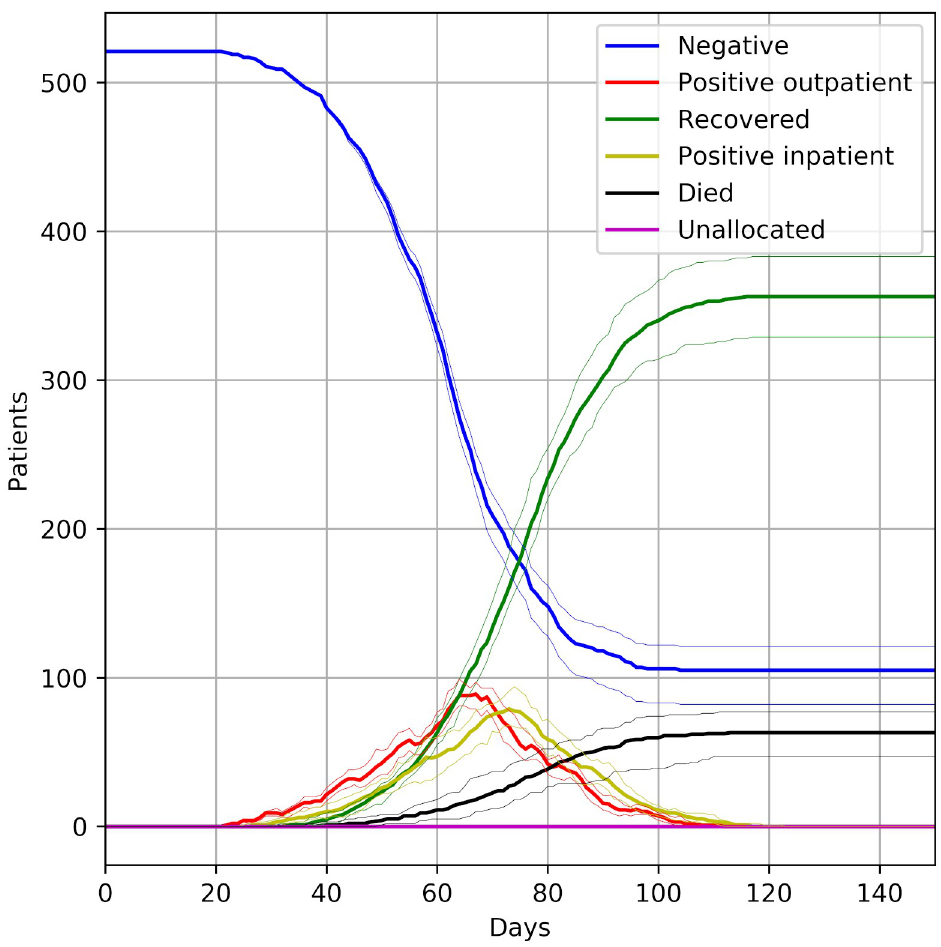
Fig 2. Patient state over time by unit. The patient population progresses through infection over three months (with 80% infected). The bold line shows the median results of 30 trials, and the fainter lines show the minimum and maximum from the 30